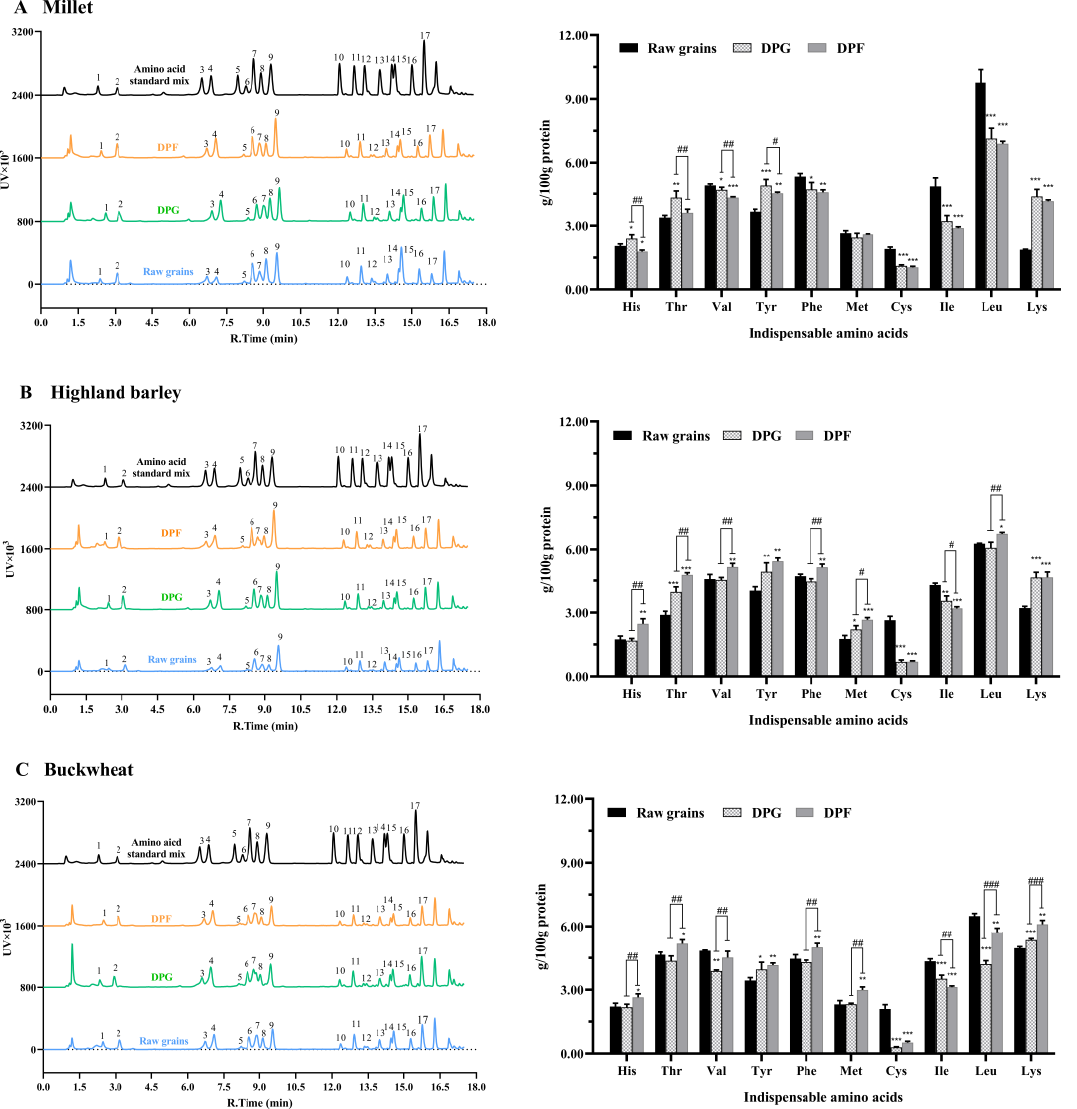
Figure 1. Amino acids composition of raw grains and digest from cereal-based foods from ( A ) millet, ( B ) highland barley and ( C ) buckwheat. Left : Chromatographs of 17 amino acids. This includes 1, Glu; 2, Asp; 3, Ser; 4, Gly; 5, His; 6, Thr; 7, Arg; 8, Ala; 9, Pro; 10, Tyr; 11, Val; 12, Met; 13, Cys; 14, Ile; 15, Leu; 16, Phe; and 17, Lys. Right : Indispensable amino acids content, g/100 g protein. DPG, simulated gastrointestinal digest from PG (cooked grains) and DPF, simulated gastrointestinal digest from PF (millet steamed buns, highland barley noodles and buckwheat noodles, respectively). Values of indispensable amino acid content were means ± SD ( n = 3). * p < 0.05, ** p < 0.01, *** p < 0.001 comparison between DPG, DPF and raw grains, respectively; # p < 0.05, ## p < 0.01, ### p < 0.001 comparison between DPG and